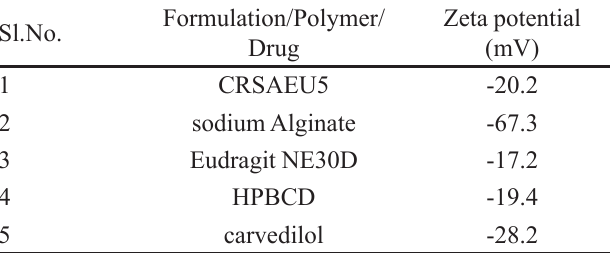
TABLE VI - Zeta potential of optimized formulation, polymers, pure drug Sl.No.